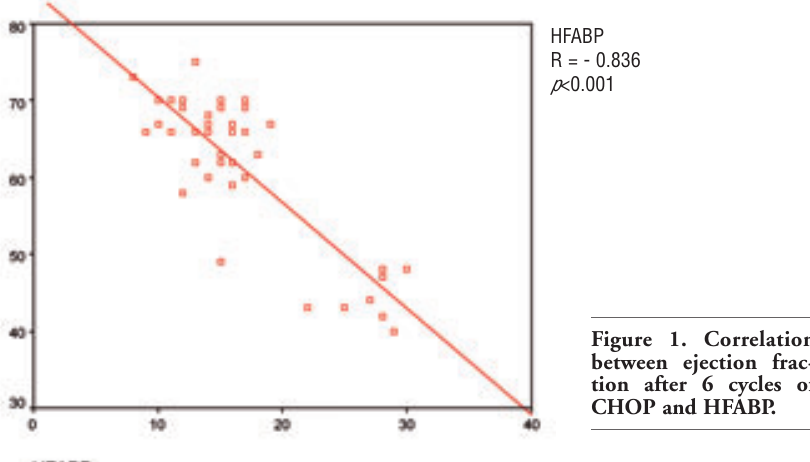
HFABP R = - 0.836 p <0.001